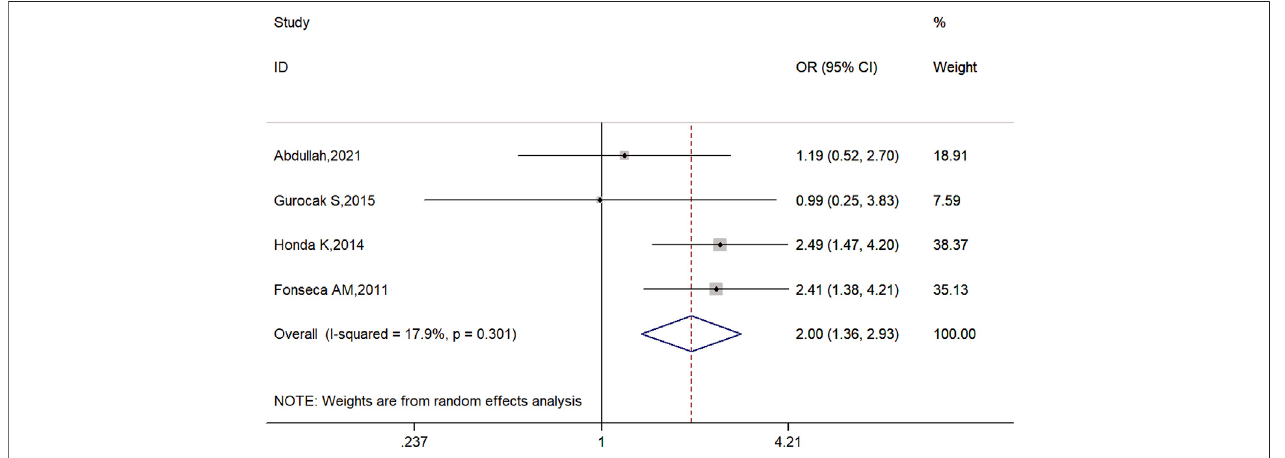
FIGURE 2 | Forest plots for the association between ADRB3 gene polymorphism and susceptibility to OAB in the allele model (C vs.